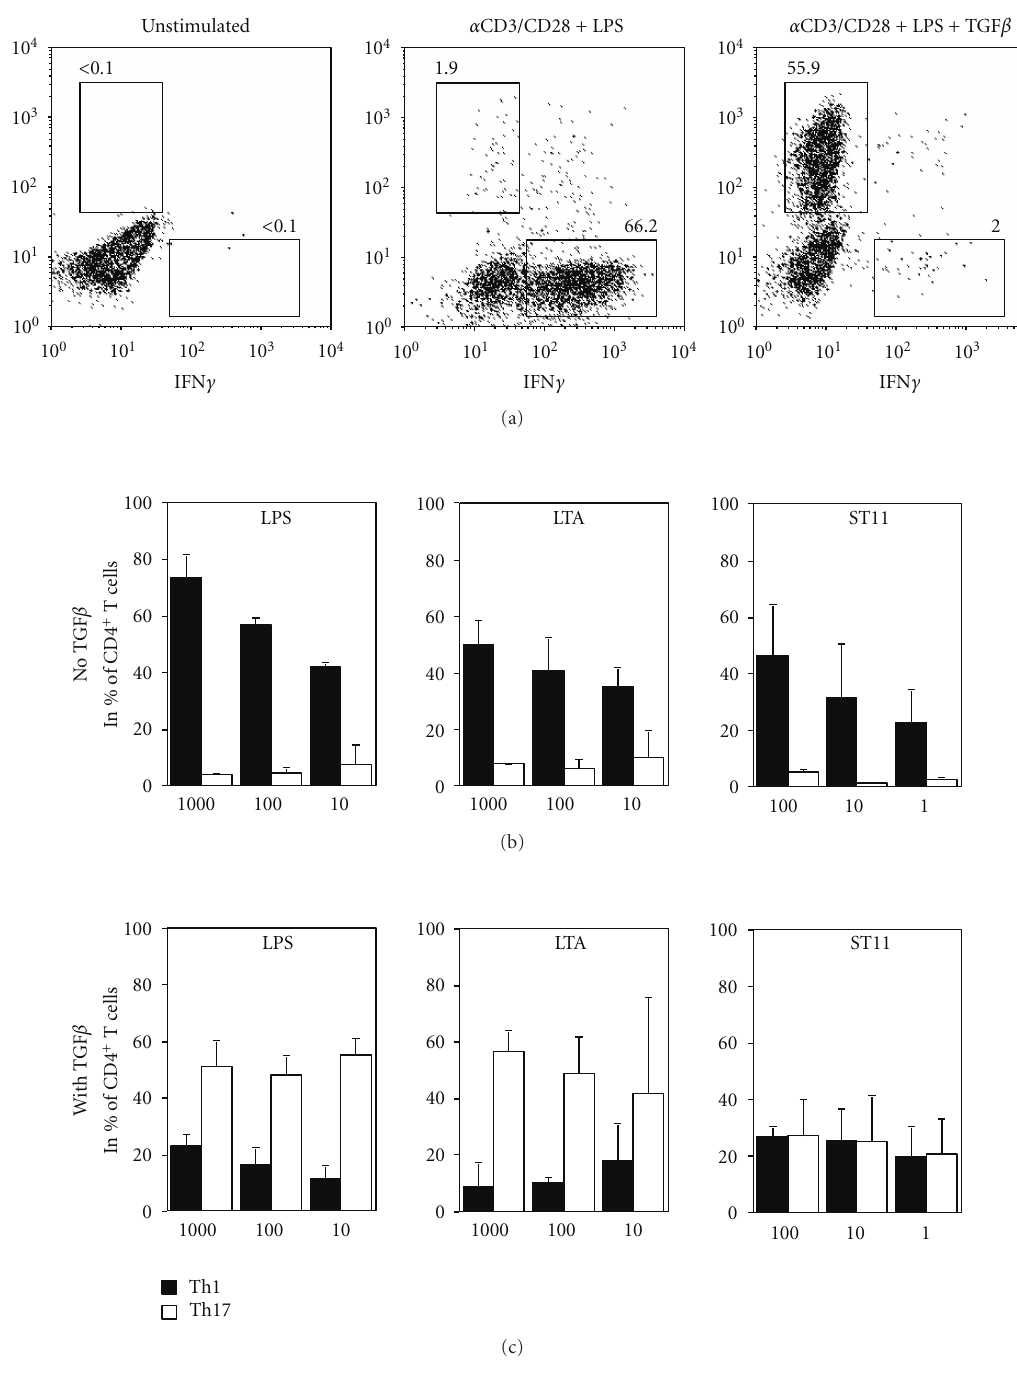
Figure 2: ST11 weakly supports Th17 cell di ff erentiation in DCT cells cocultures. (a) BM-DCs were cocultured with sorted na¨ıve CD4 + T cells for 4 days at DC: T cell ratio of 1:2.5 in the absence or the presence of TGF β (5ng/mL). Then, cells were stimulated, fixed, and intracellularly stained for T helper 1 (Th1 being IFN γ + ) or T helper 17 (Th17 being IL-17 + ) cell quantification by flow cytometry. Representative dot-plots are shown, numbers indicate % of a gated population. Combination of proinflammatory signals and TGF β are mandatory for Th17 cell di ff erentiation. (b) Bar graphs represent mean % values ± SD of Th1 (CD4 + IFN γ + IL-17 − T cells, black-filled bars) and Th17 (CD4 + IFN γ − IL-17 + T cells, unfilled bars) obtained in three independent experiments in the absence (a) or the presence (c) of TGF β and analyzed by flow cytometry. As proinflammatory signal, either LPS, LTA, or ST11 was used in a dose-dependent manner. Doses are given in ng/mL for LPS and LTA or bacteria: DC ratio for